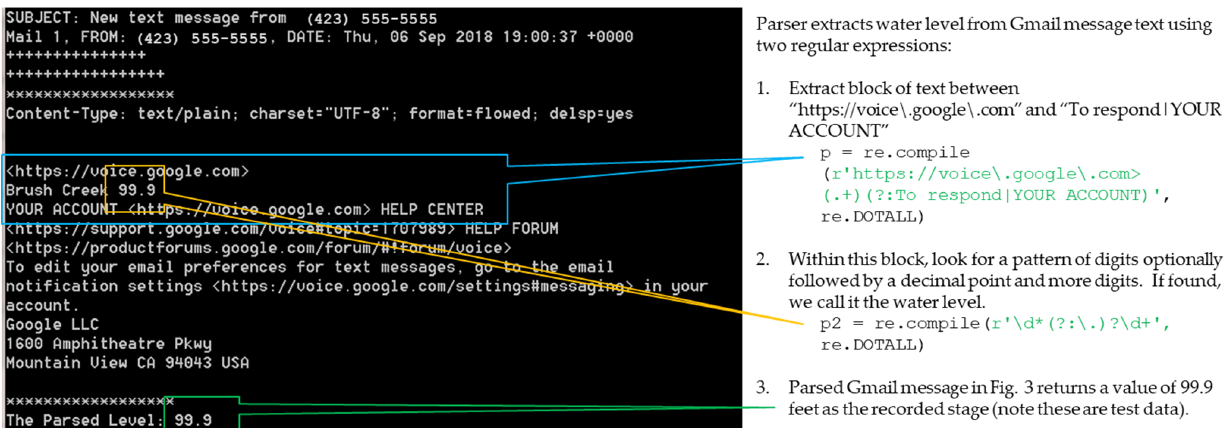
Figure 2. Educational sign provides instructions for data collection and contribution via text message.